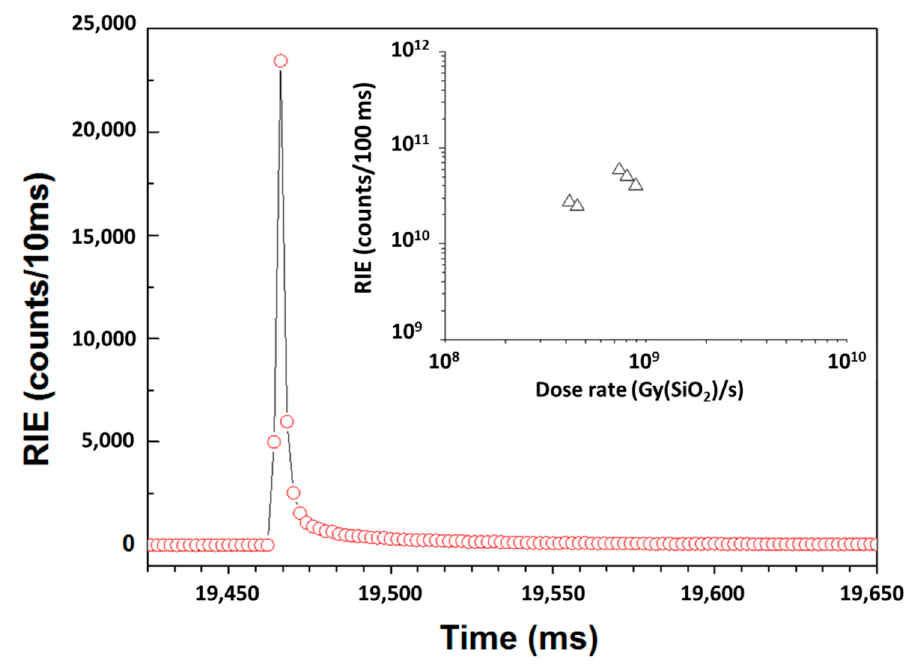
Figure 8. Illustration of the detected RIE for the N-doped sample before, during and after an X-ray shot at ASTERIX. In the inset are the reported normalized RIE corresponding to the dose rates associated with the 5 different shots (black triangles).